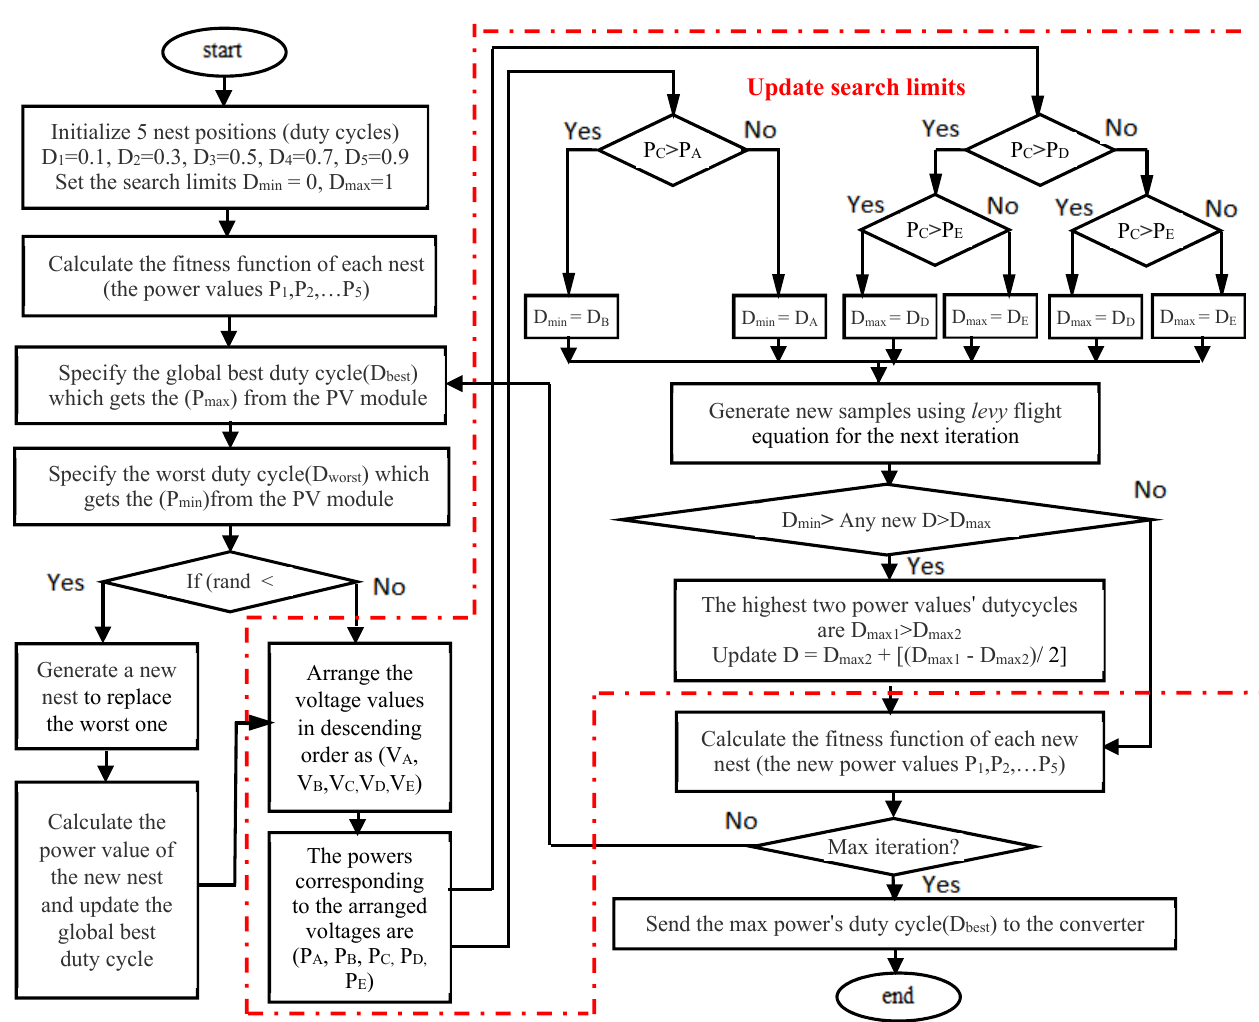
Figure 6. The new position of the weakened duty cycles towards the GMPP. The flowchart of the proposed technique can be simplified, as in Figure 7.